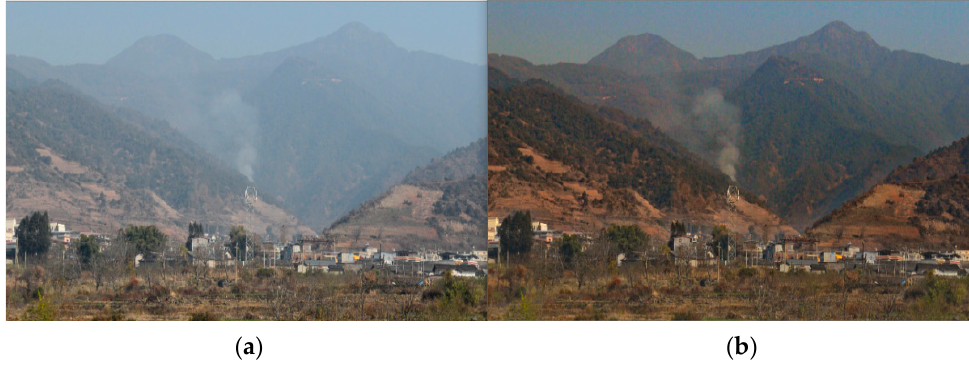
Figure 6. Defogging effect: ( a ) is the original image and ( b ) is the image after defogging.